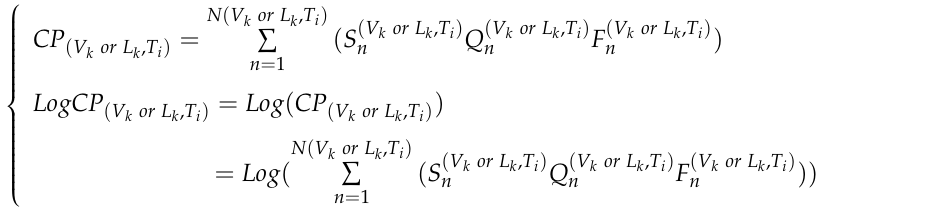
Figure 2. Constructing a maritime network from Automatic Identification System (AIS) data. (a) AIS point, (b) maritime network between ports, (c) maritime network of 21C-MSR countries and other countries.